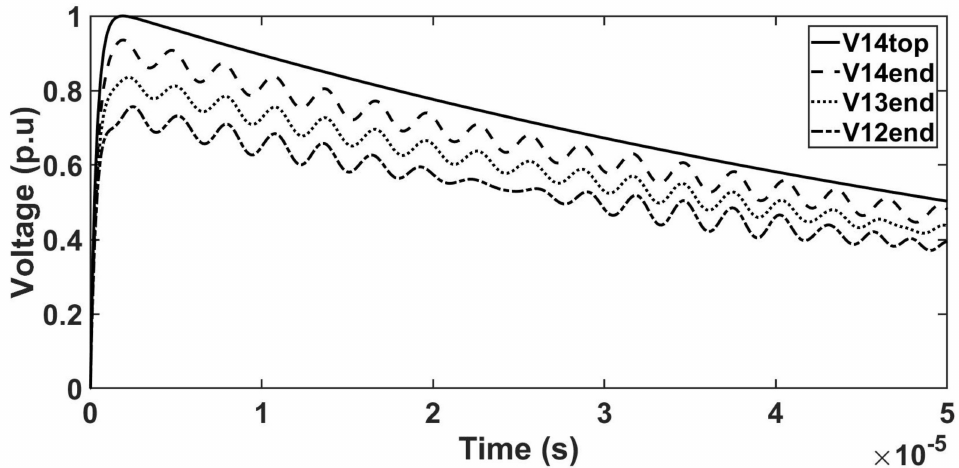
Figure 19. Surge voltage waveforms for shield placement between HV and LV windings under SLI.